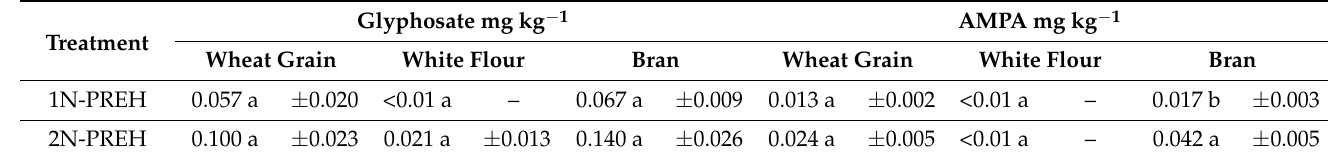
Table 3. The influence of pre-harvest (PREH) application, at maximum (1N) and double (2N) label rates, on glyphosate and AMPA residues in harvested spring wheat grain, as well as in its final products, 2021.